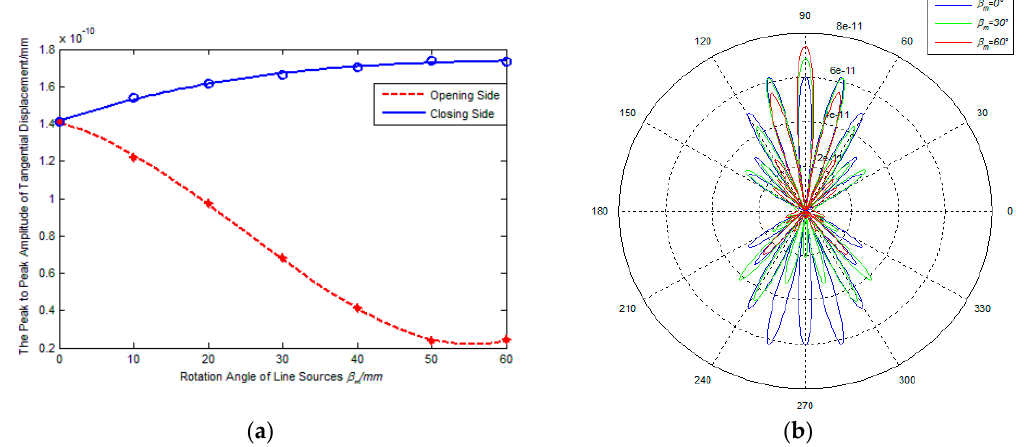
Figure 6. Effects of β m on performance of PPM EMATs ( d = 60 mm): ( a ) β m -signal amplitude; ( b ) β m -radiated acoustic field.